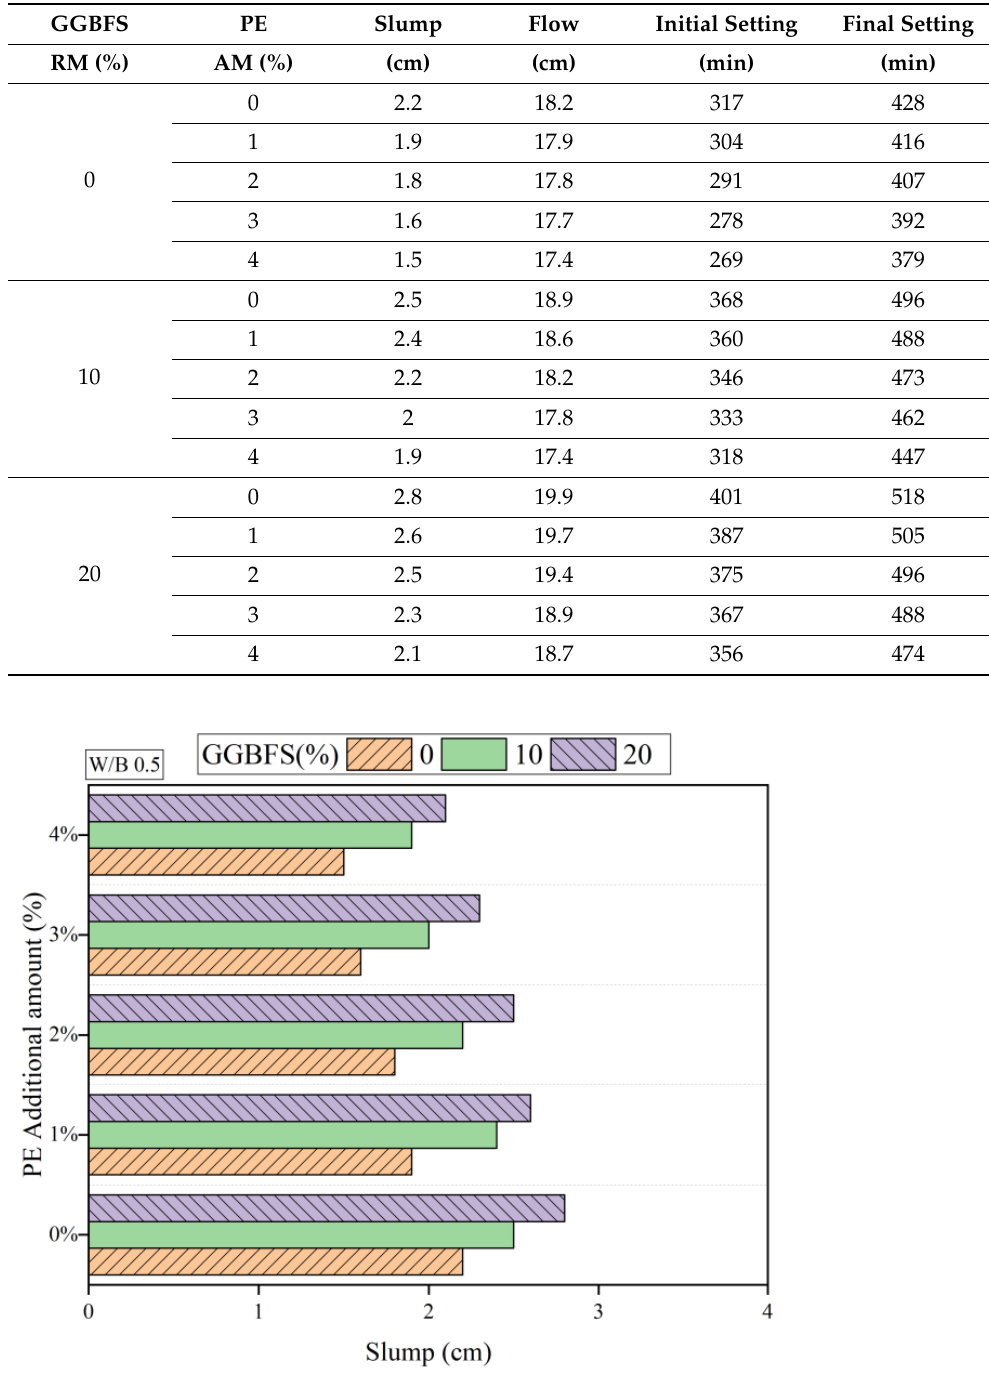
Table 4. Fresh properties of cement mortar with the addition of different ratios of waste PE and GGBFS replacement.